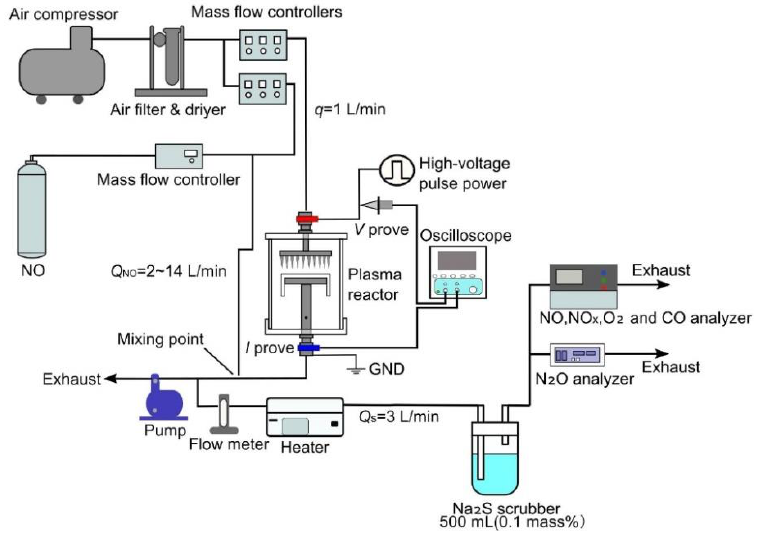
Figure 3. Schematic diagram of the experimental setup for indirect plasma oxidation method.